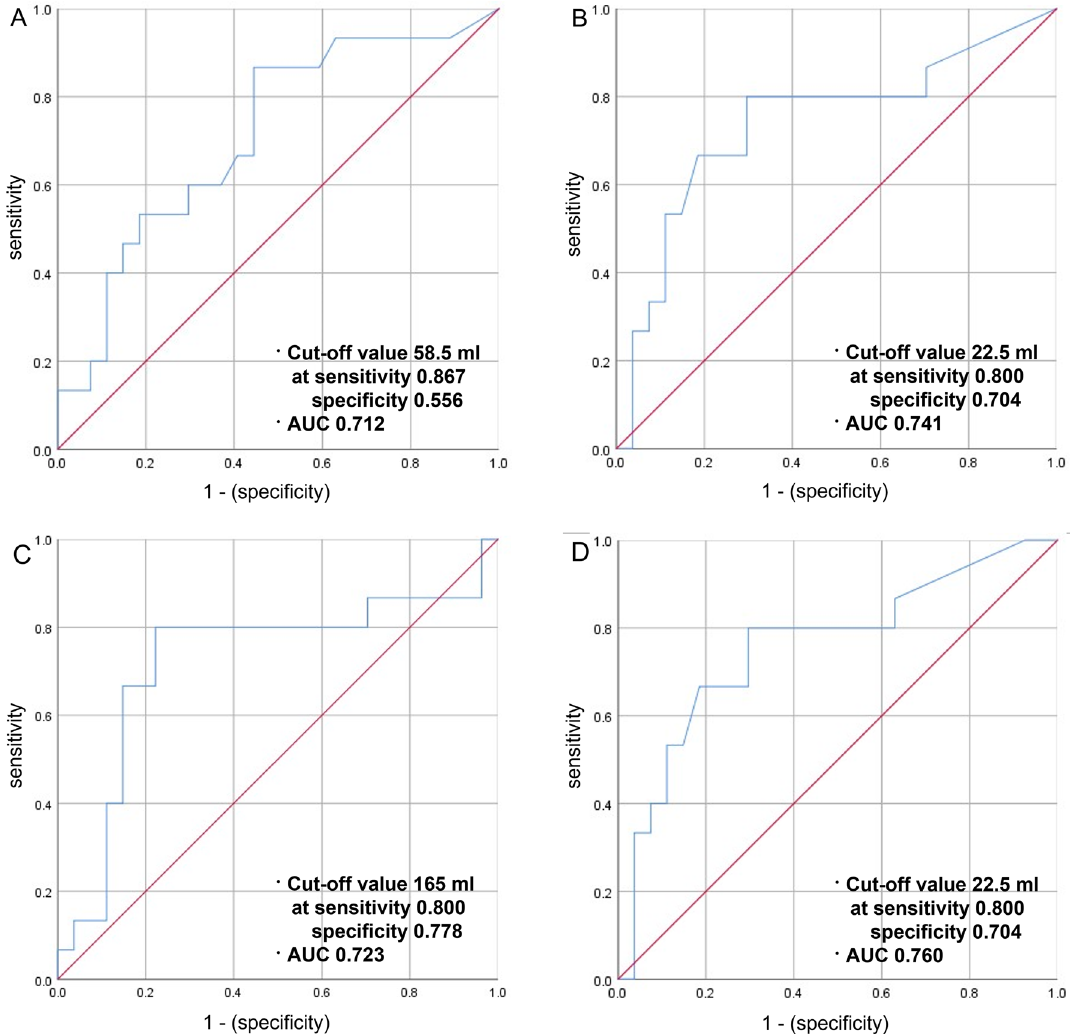
Figure 4. ( A ) The preoperative mismatch volume was observed to be significantly different in the positive and negative outcome group ( p = 0.044). The AUC was 0.712 and the cut-off value was 58.5 mL. ( B ) The immediate postoperative Tmax > 6 s showed significant difference in the positive and negative outcome group ( p = 0.027). The AUC was 0.741 and the cut-off value was 22.5 mL. ( C ) The immediate postoperative Tmax > 4 s in the positive and negative outcome group was significantly different ( p = 0.039), and the AUC and the cut-off value swere 0.723 and 165 ml, respectively. ( D ) The immediate postoperative mismatch volume in the positive and the negative outcome group presented significant difference ( p = 0.020). The AUC and the cut-off values were 0.760 and 22.5 ml,